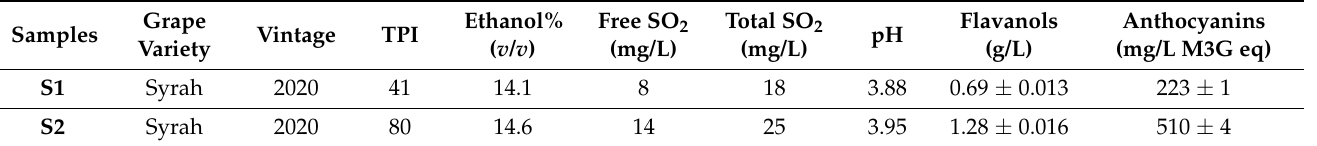
Table 2. Classical oenological parameters and phenolic characterization of the different Syrah red wines. Values represent means of triplicate determination ± standard deviation. M3G eq: Malvidin- 3-O-glucoside